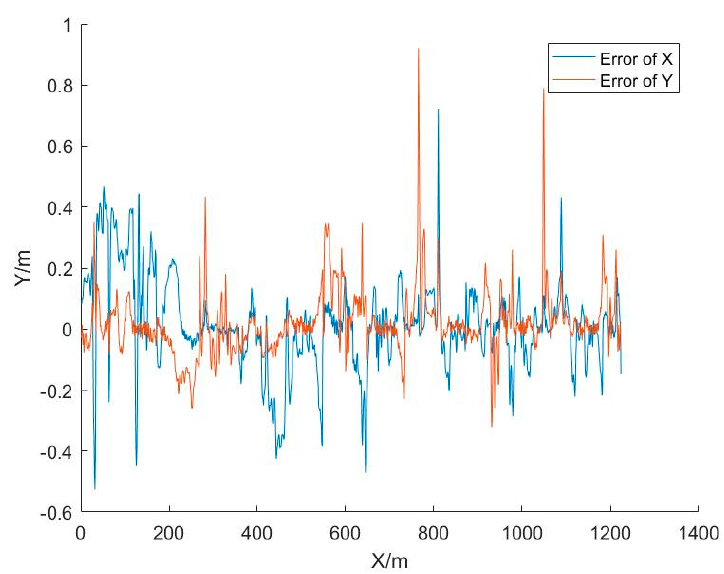
Figure 11. The positioning errors of the UWB and vision combination.